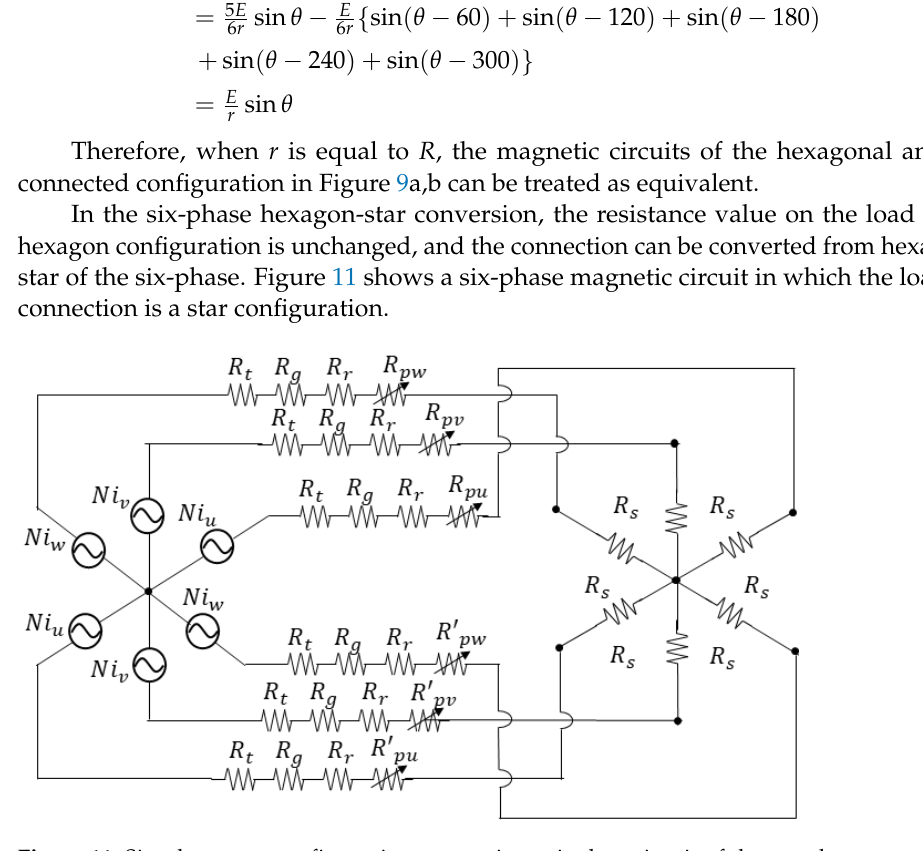
Figure 11. Six-phase star configuration magnetic equivalent circuit of the novel consequent-pole PM motor.